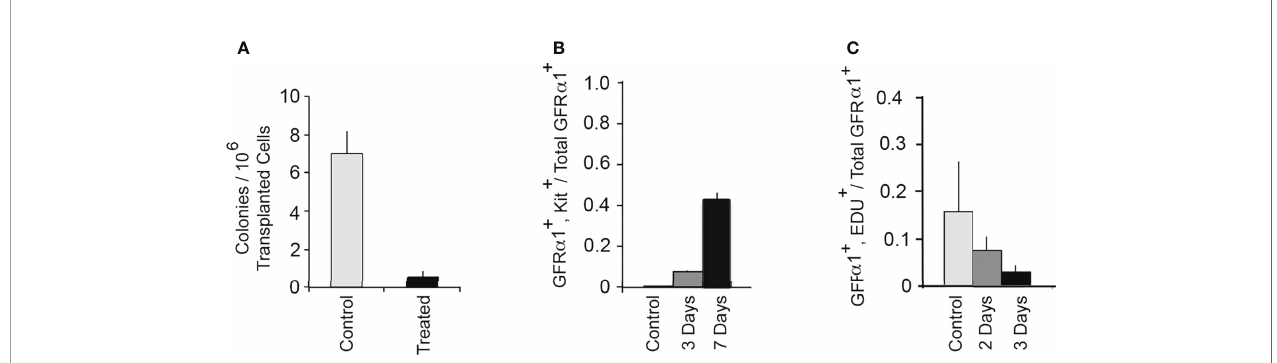
FIGURE 2 | GDNF is essential for sustaining SSCs in an adult mouse testis. (A) Effect of inhibition of GDNF signaling for 9 days on numbers of transplantable SSCs. The Ret (V805A) mice used in this study were heterozygous for bacterial b − galactosidase ( Rosa 26 ) and for Id4-GFP . Adult mice were injected daily for 9 days with 1NAPP1 (treated) or with vehicle (control). Two to four days after the last injections, germ cells were isolated from these mice, transplanted into testes of germ cell- de fi cient mice, and testes analyzed 2 months after transplantation. Numbers of transplanted SSCs were estimated by enumerating colonies of Rosa 26 + spermatogenic cells in each testis. Data (mean + SEM) demonstrate that inhibition of GDNF signaling for 9 days results in loss of 90% of transplantable SSCs. Data are from: (16). (B) Inhibition of GDNF signaling results in rapid differentiation of SSCs. In this experiment we de fi ned SSCs as GFR a 1 + , A single (A s ) spermatogonia, and we used their co-expression of Kit to identify differentiating cells (1). Adult Ret(V805A) mice were treated with vehicle or with 1NAPP1 for 3 or 7 days, seminiferous tubules collected 24 hours after the last injection, and tubules processed for identi fi cation of both GFR a 1 + and GFR a 1 + , Kit + A s spermatogonia. Data (mean + SEM) are presented as numbers of GFR a 1 + , Kit + A s spermatogonia divided by total numbers of total GFR a 1 + A s spermatogonia. Results demonstrate that in control mice, only 0.0008 of all GFR a 1 + , A single (A s ) spermatogonia express Kit. However, after 3 and 7 days of treatment with 1NAPP1, 0.08 and 0.42, respectively of all GFR a 1 + A s spermatogonia, expressed Kit. Data are from: (20). (C) Acute inhibition of GDNF signaling causes a rapid decrease in replication of SSCs in normal, mature testes. Ret(V805A) mice were injected with 1NAPP1 for 2 or 3 days, and also with the thymidine analogue, EdU on the last day of treatment. Tubules were collected 24 hrs. later and processed for detection of GFR a 1 and EdU incorporation. Data are expressed as fraction of all GFR a 1 + , A s spermatogonia, that had incorporated EdU + . Results (mean + SEM) demonstrate that inhibition of GDNF signaling results in a rapid decrease in SSC replication. After 3 days, this replication was reduced to 19% of control. Data are from: